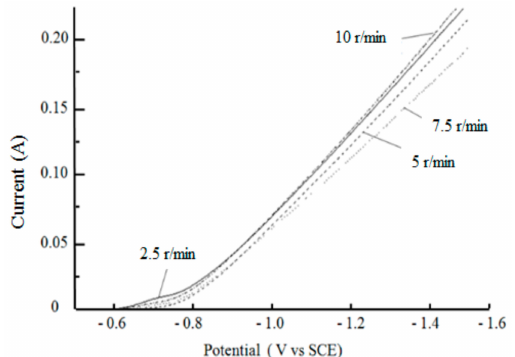
Figure 10. Cathodic polarization curves tested under di ff erent stirring